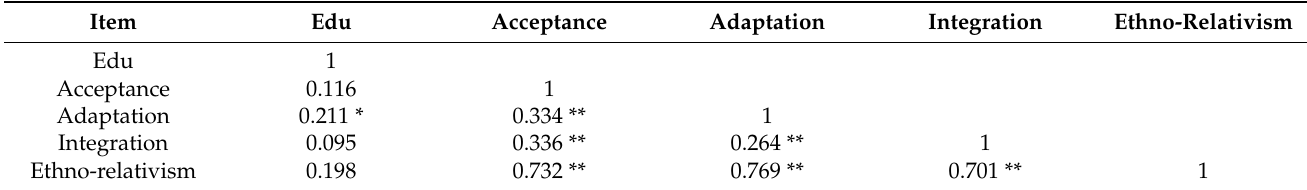
Table 9. Correlation analysis of means of ethnorelativism parameters and academic education level of participants.